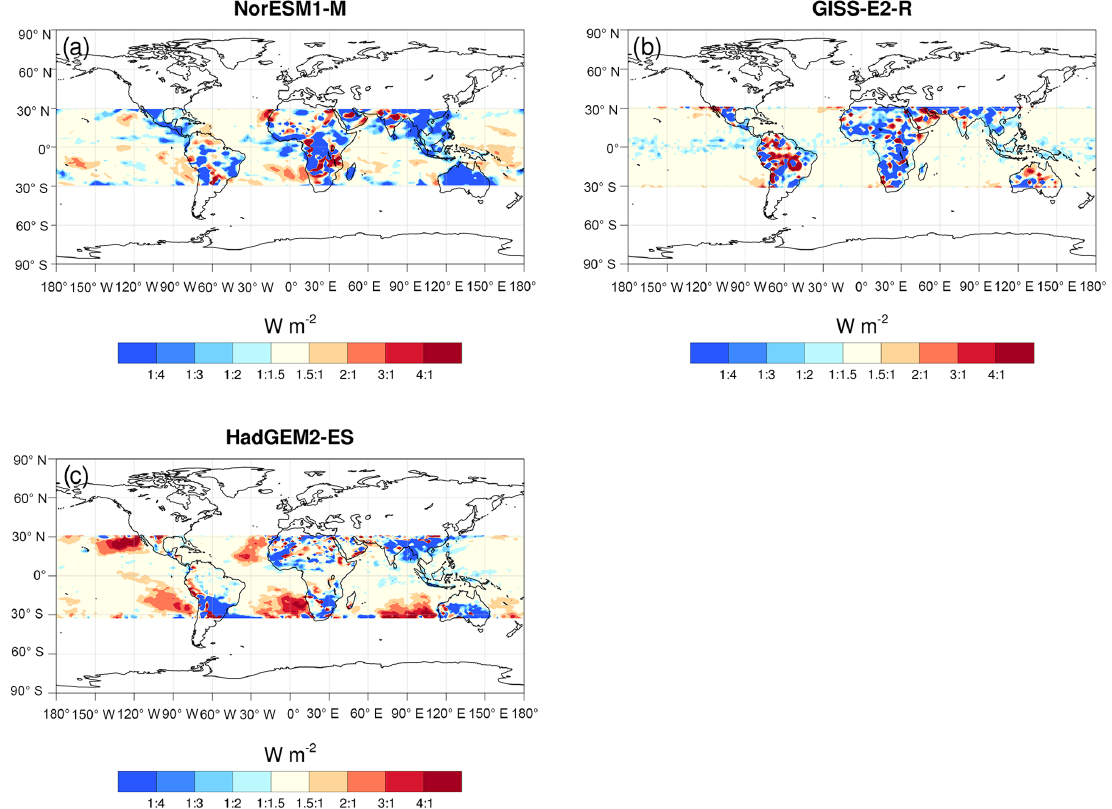
Figure 5. The ratio of the total ERF to the clear-sky ERF at the TOA averaged over the 10 years of simulation with fixed SST for (a) NorESM1-M, (b) GISS-E2-R, and (c)